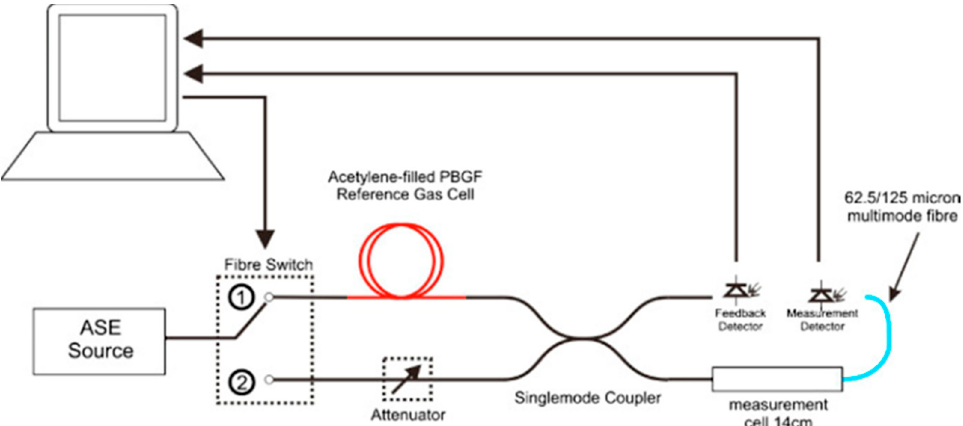
Figure 4. Experimental setup. DFB laser: distributed feedback laser; HC-PCF: hollow core photonic crystal fiber (in the paper figure as called PBGF); SMF: single-mode fiber; MMF: multi-mode fiber; PD: photodetector; PC: personal computer. Reprinted with permission from [61].